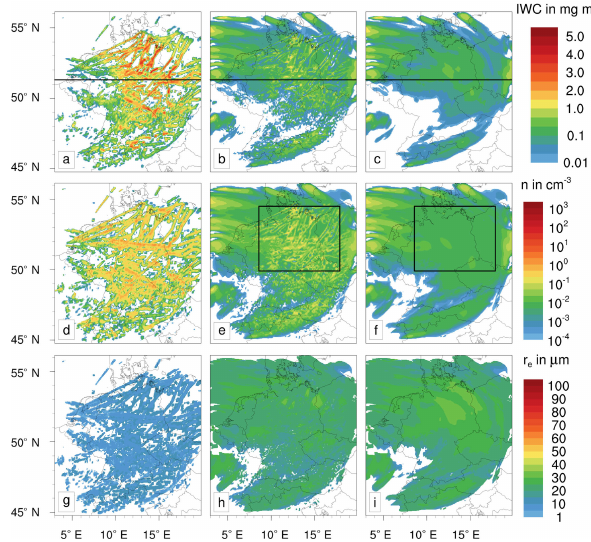
Figure 4. Analogous to Fig. 3, now for 12:00UTC. The black hori- zontal lines indicate the location of the curtain displayed in Figs. 5 and 7; black boxes are discussed in the text.